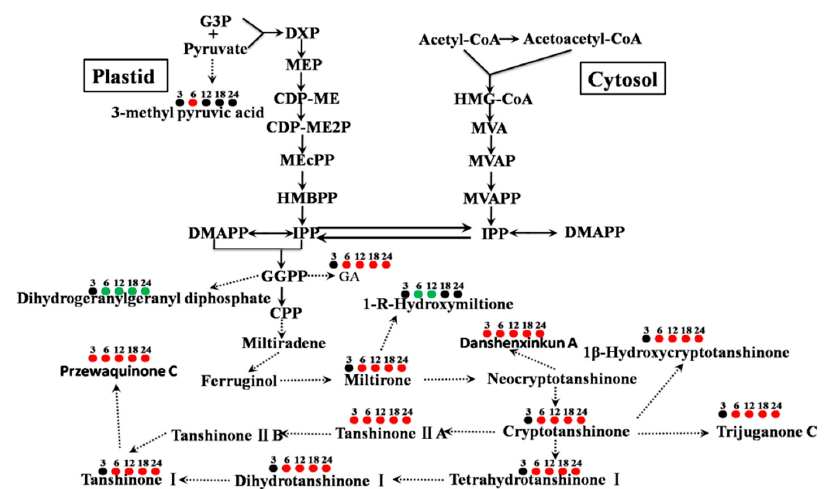
Figure 6. Changes of metabolites associated with tanshinones biosynthesis in S. miltiorrhiza hairy roots with PSF treatment. The circles associated with the metabolites indicate whether the metabolite was up-regulation (red), down-regulation (green), or no differences (black) and the numbers above the circles mean the days after PSF treatment.